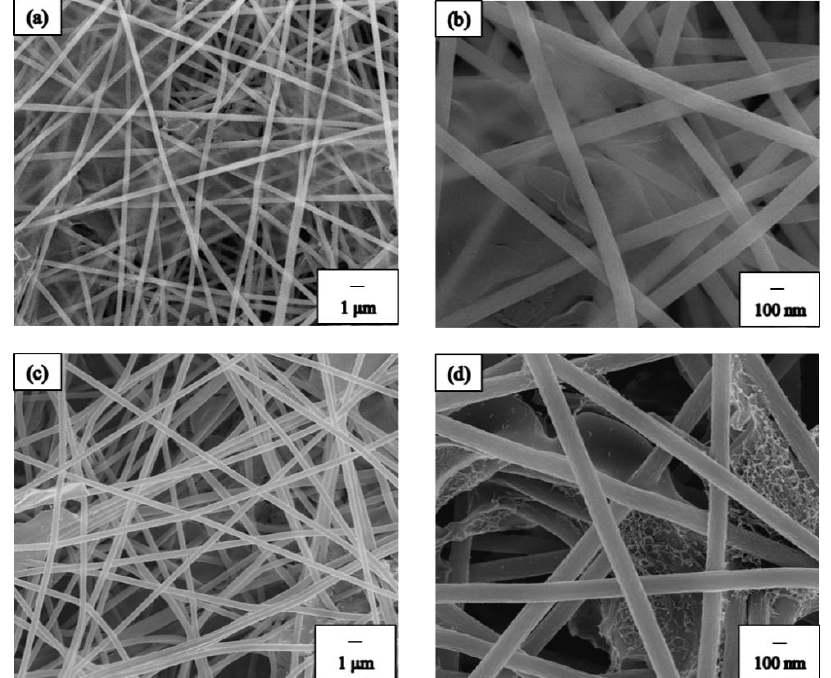
Figure 3. FE-SEM images of directive spray coating process: ( a ) low magnification, ( b ) high magnification; electrospinning and spraying composite process: ( c ) low magnification, ( d ) high magnification.